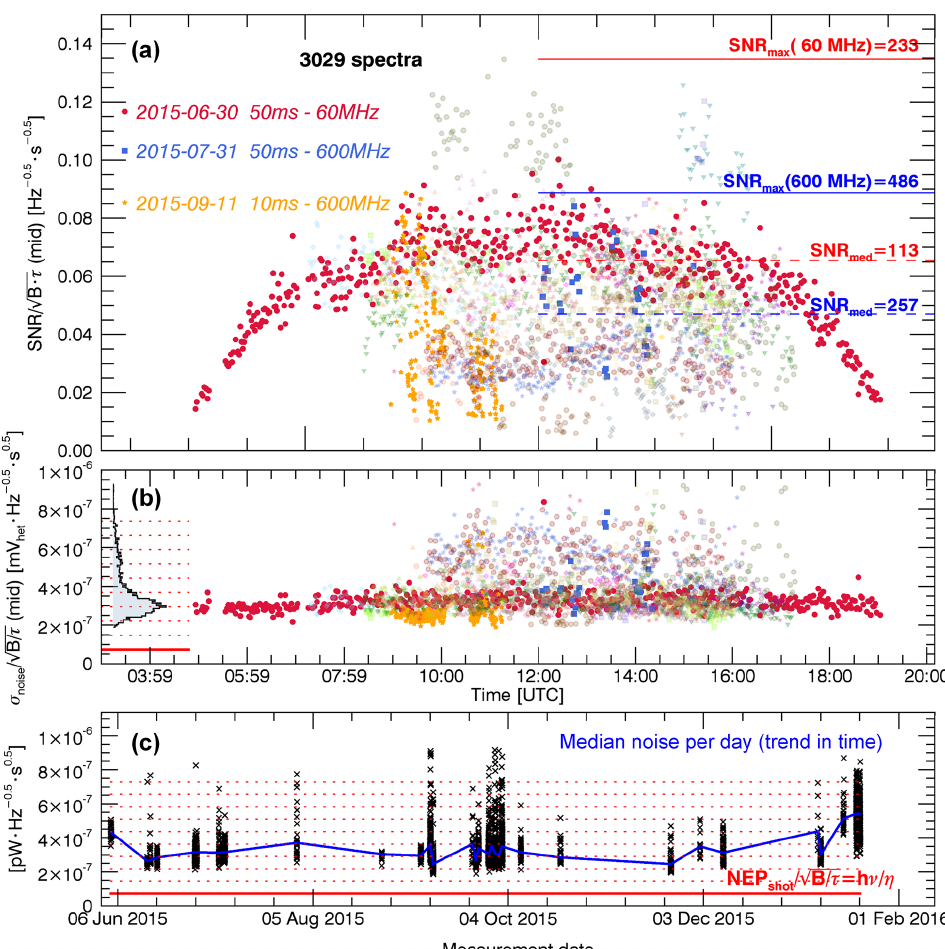
Figure 7. LHR radiometric performance analysis over the full archive of quality-controlled spectra. Only the three most relevant measurement dates for the analysis are given in the legend to improve clarity. (a) Normalized (see text for details) midsection (953.15 ± 0.05cm − 1 ) SNR; the maximum and median SNR text values from the entire measurement series are not normalized, but their locations (horizontal lines) in the plot are. (b) Normalized midsection measurement noise in heterodyne voltage units (i.e. factoring out lock-in amplifier sensitivity settings). The noise is estimated as 1 standard deviation of the midsection signal segment, corrected for the baseline variation. The histogram on the left shows the corresponding statistical distribution, (c) Normalized noise converted into a radiant flux (see text) as a function of date and time of measurement. Black crosses correspond to the same individual measurements as in (b) , but plotted on a running time axis; occasionally, the scatter within a single day is large, although measurements mostly clump around a similar value (see median curve). The red solid and broken lines correspond to the theoretical shot noise limit and consecutive multiples